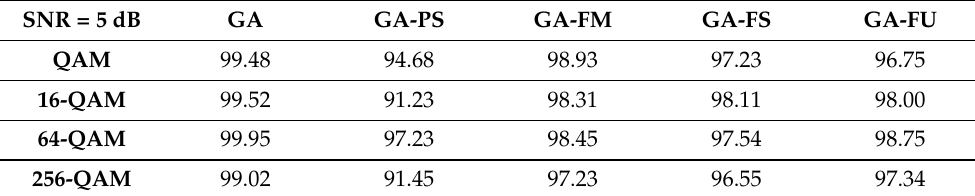
Table 3. ACA for M-QAM signals with IRS.